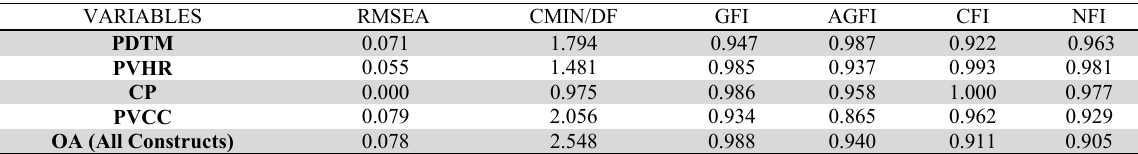
Model fit estimates for